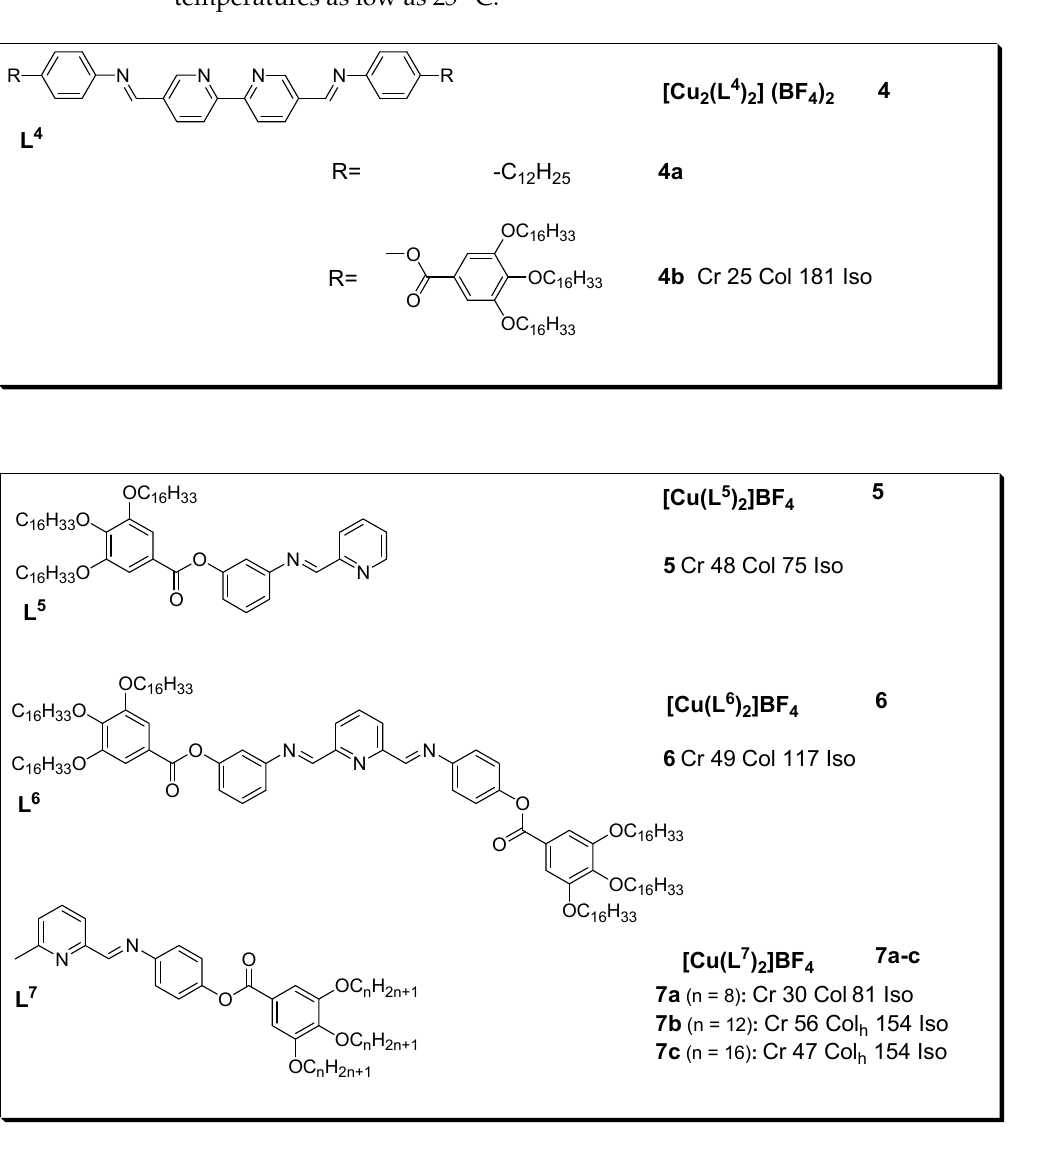
Figure 4. Copper(I) metallomesogens with Schiff bases. All transition temperatures are in °C (transition temperature for 4a not reported) [43–45].